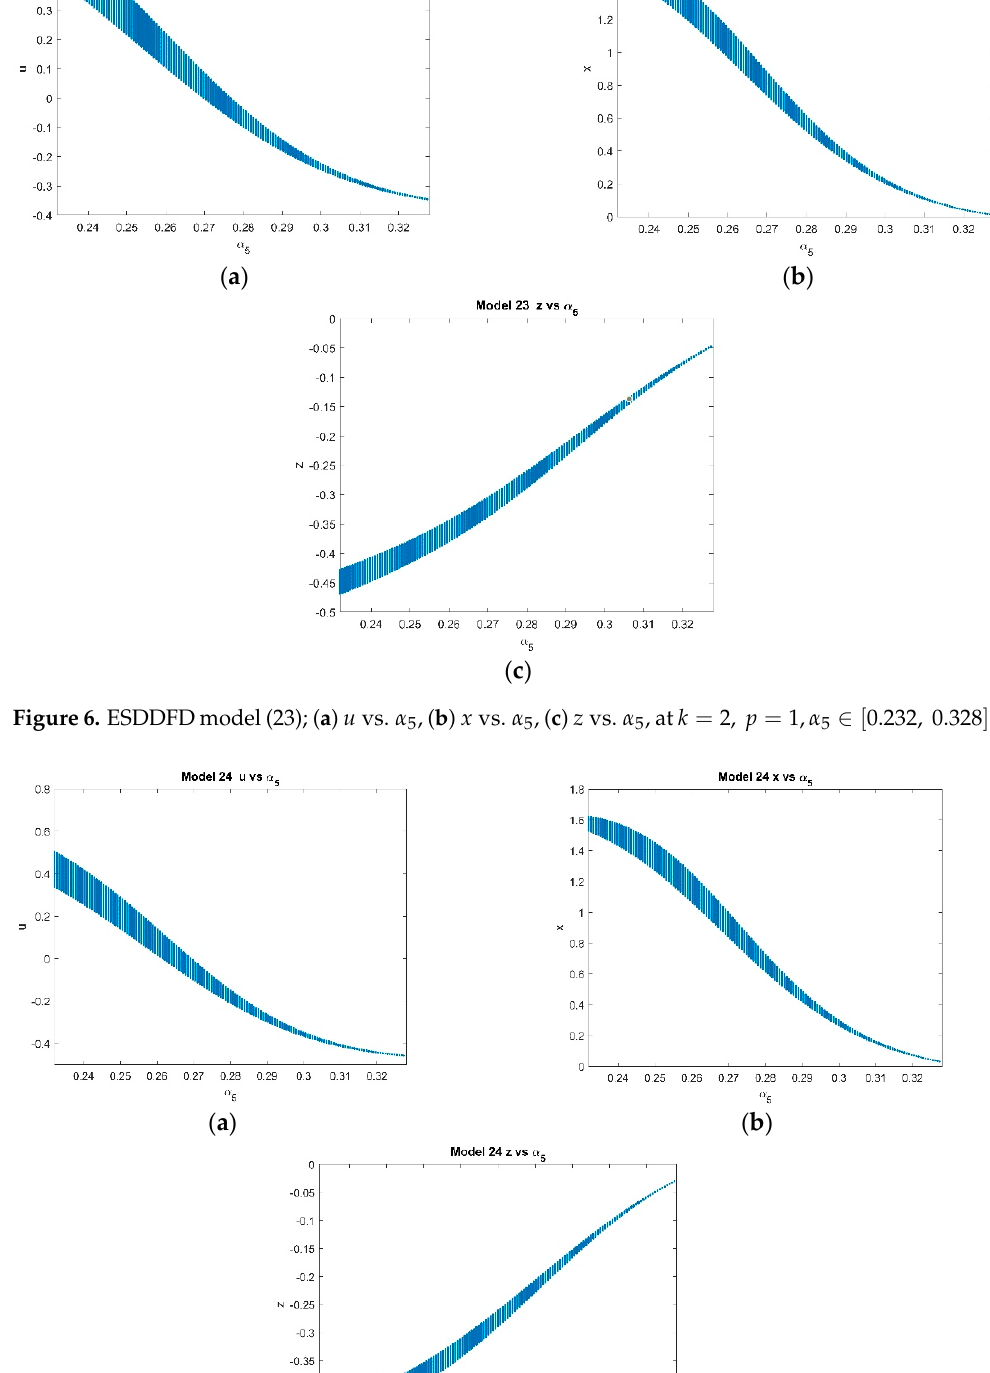
Figure 5. MCEFD Model (22); ( a ) 𝑢 vs 𝛼 (cid:2873) , ( b ) 𝑥 vs 𝛼 (cid:2873) , ( c ) 𝑧 vs 𝛼 (cid:2873) , at 𝑘 = 2,𝑝 = 1, 𝛼 (cid:2873) ∈ [0.232, 0.328(cid:4671) .